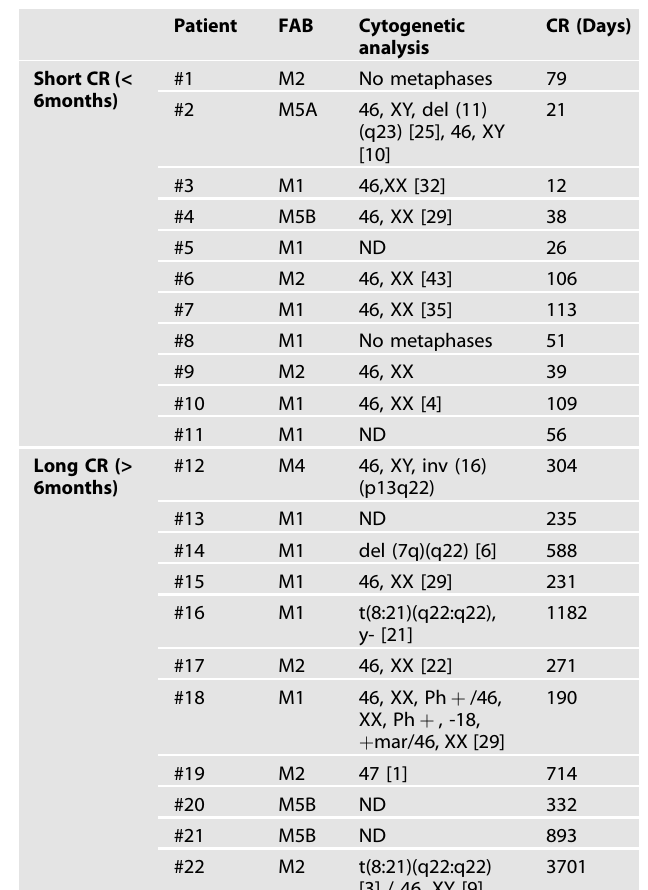
Table 1. Characteristics of the AML